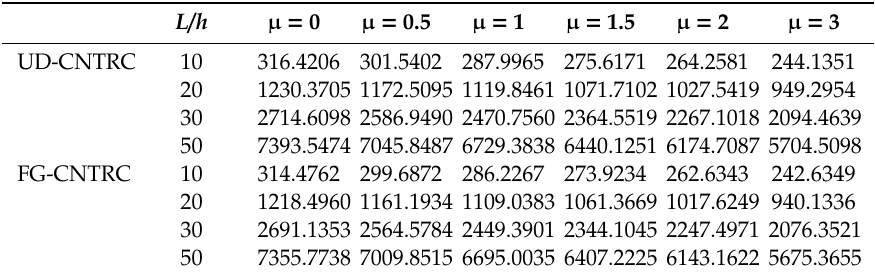
Table 8. E ff ect of the slenderness ratio L / h on the nondimensional critical buckling load for C-C CNTRC = 0.14. curved beams with α = π / 3, V ∗ CNT